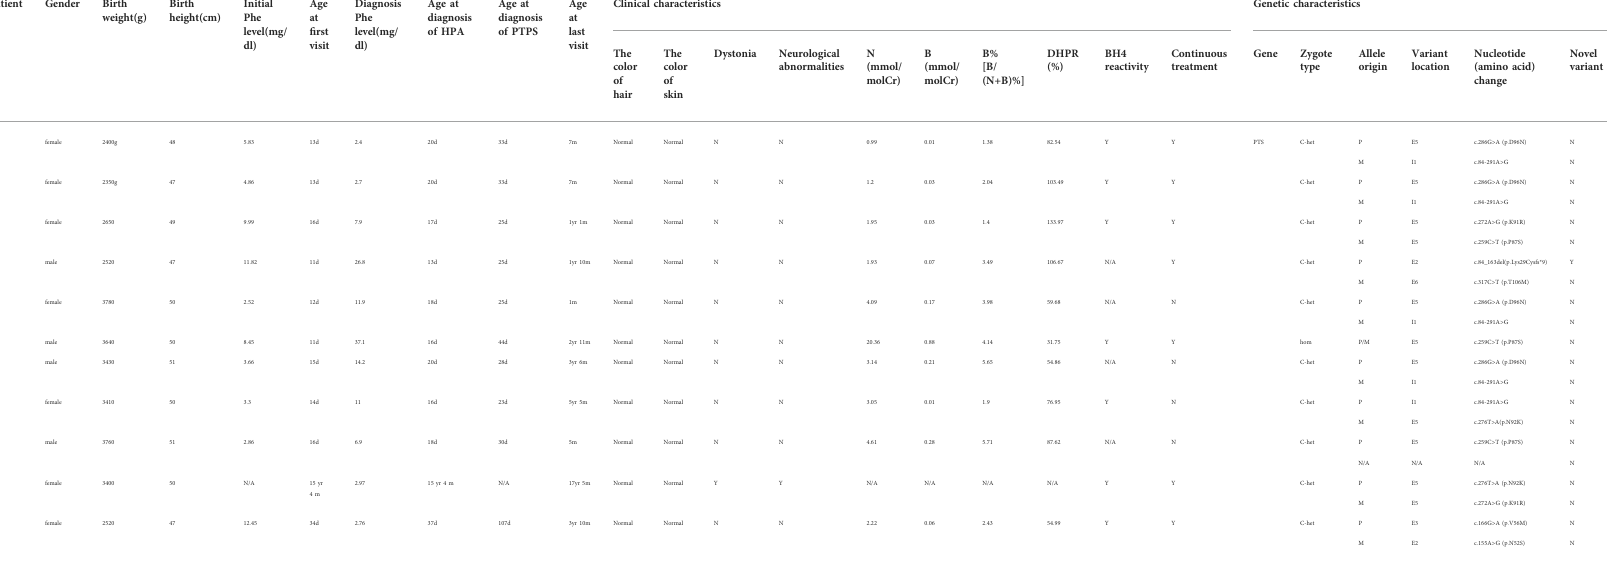
TABLE 1 Clinical and genetic characteristics of patients recruited in this